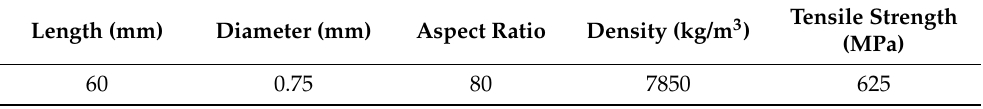
Figure 2. Glued Steel fibers. Table 4. Physical properties of steel fibers.